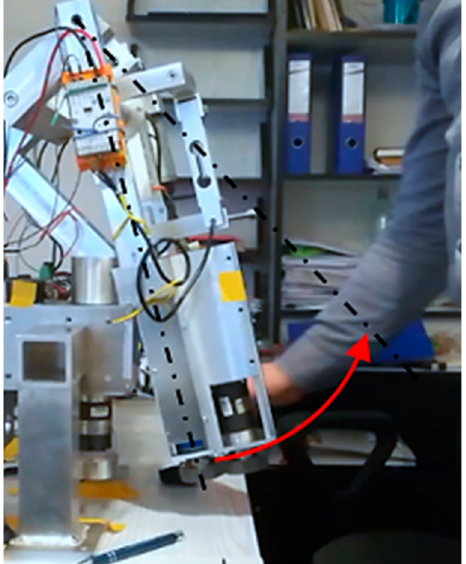
Figure 18. Setting the start position for the 𝜑 (cid:2870)(cid:3017)